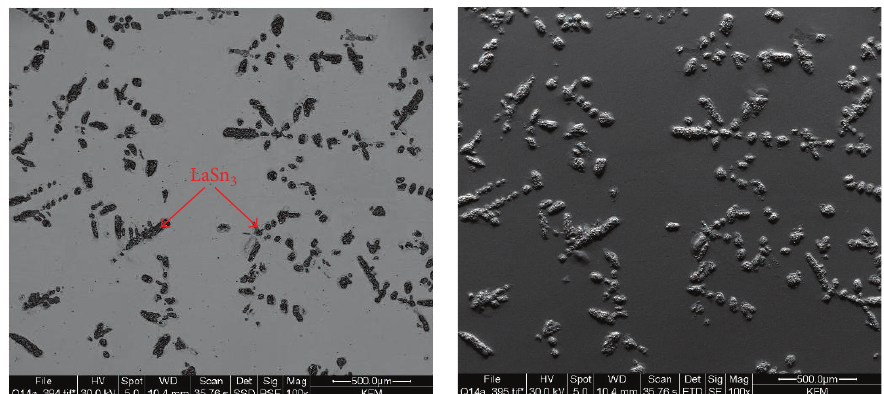
Figure 6: Microstructure of Sn2La solder.